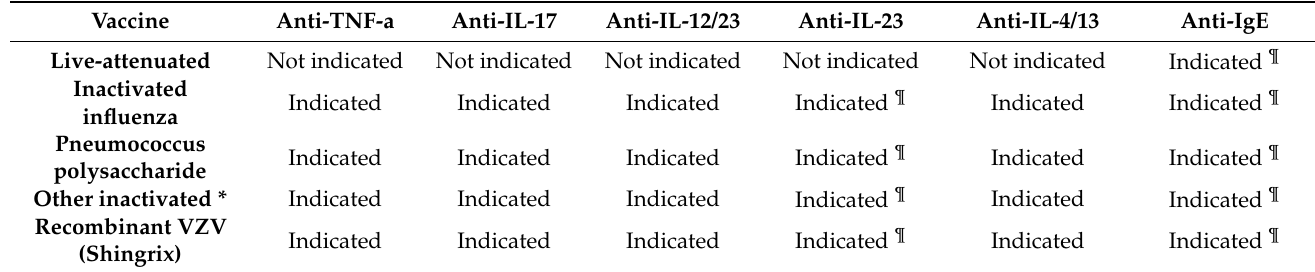
Table 1. Available vaccines and biologic